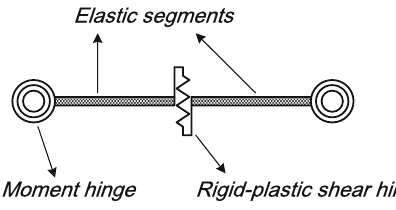
Fig. 8 Modeling of connecting